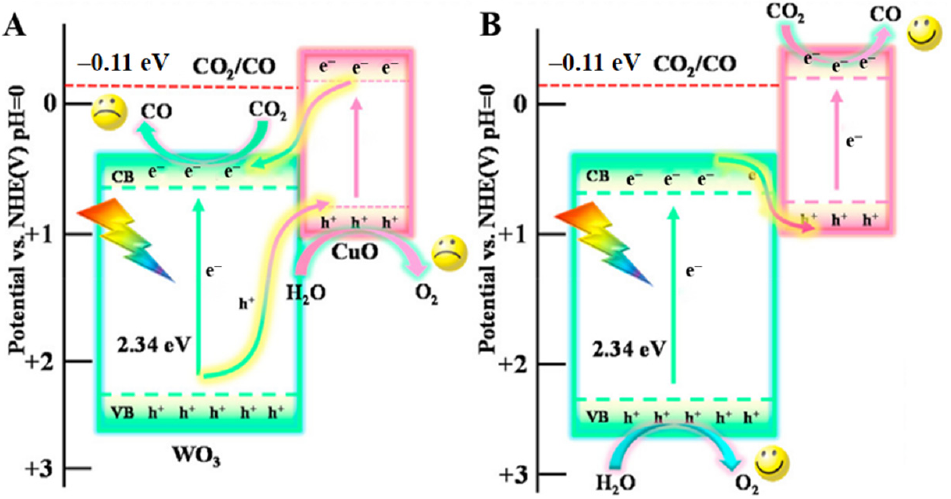
Figure 11. The proposed charge transfer mechanisms: ( A ) II-scheme and ( B ) Z-scheme for CuO/WO 3 [81].